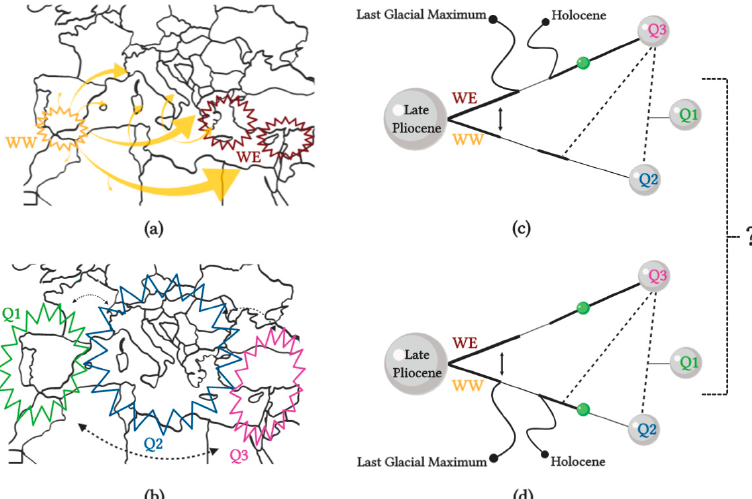
Figure 6. Single or multiple independent domestications for cultivated olive trees, the unanswered question: ( a , b ) distribution olive genepools in the Mediterranean Basin, accordingly to Besnard et al. [104] and Díez et al. [105], respectively; ( c , d ) simplified scenarios of domestication; ( c ) one single primary domestication event; ( d ) two independent primary domestication events. Green spheres indicate the primary domestication events, horizontal arrows indicate the possible occurrence of gene flow and the dashed horizontal connections indicate the admixture events (schematic representation made in ©BioRender—biorender.com).